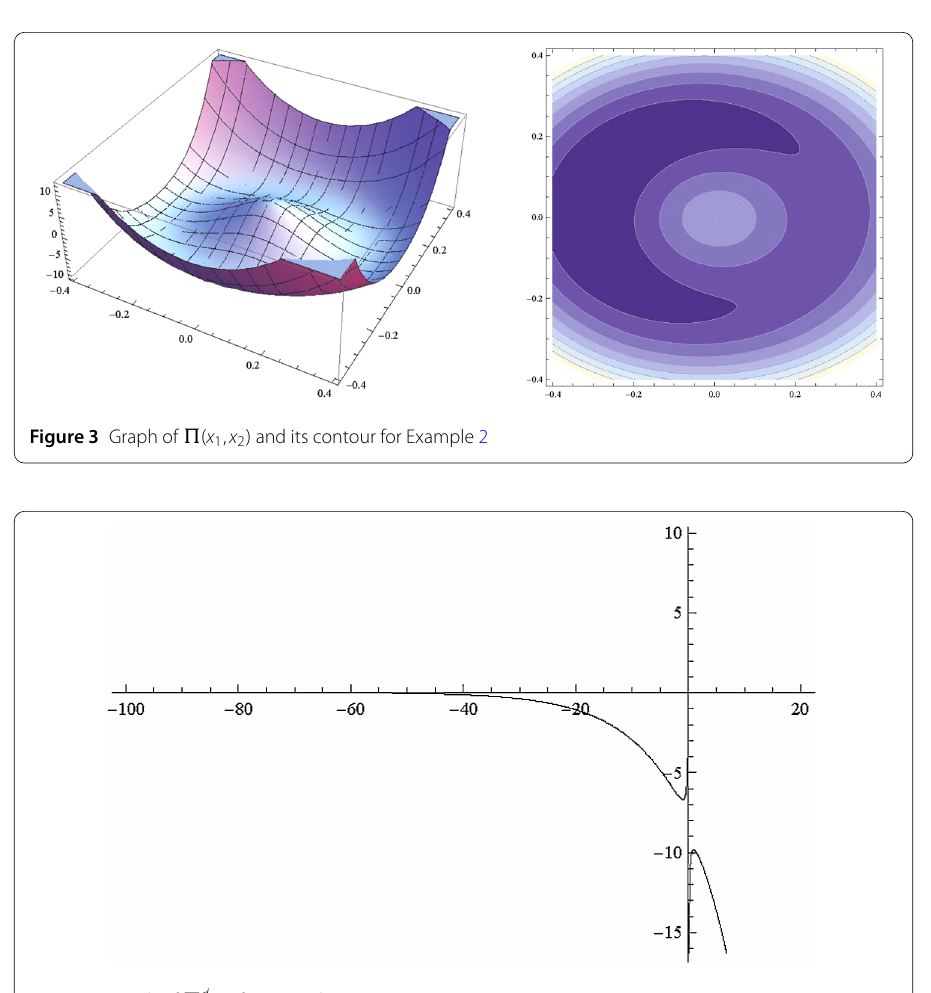
Figure 4 Graph of (cid:2) d ( ς ) for Example